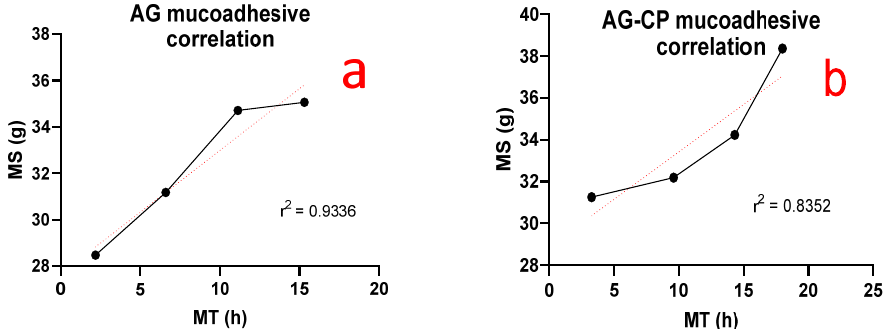
Figure 11. Correlation between ex vivo mucoadhesive strength and mucoadhesive time in healthy volunteers in ( a ) AG based gels (F1–F4) and ( b ) AG-CP based gels (F9–F12).